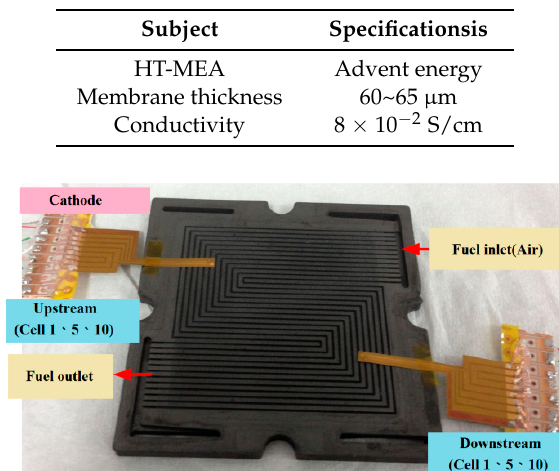
Figure 8. Position of five-in-one micro-sensors in cathode channel plates.